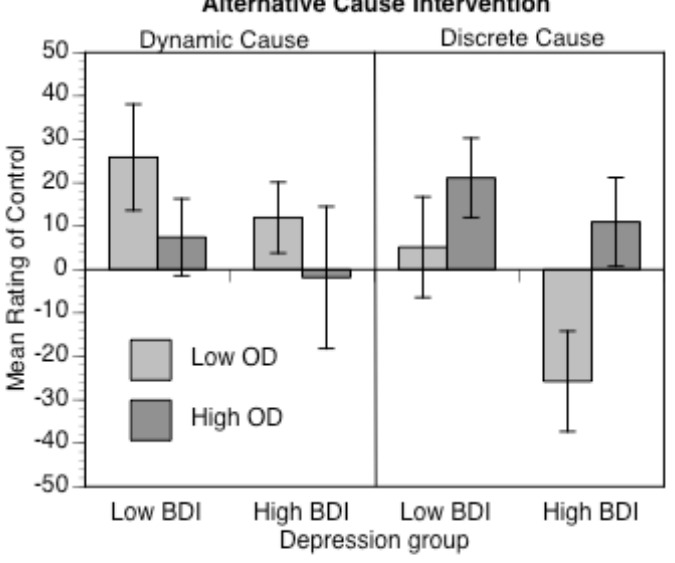
Figure 3. Mean ratings of control as a function of outcome density, Beck Depression Inventory (BDI) group and alternative cause intervention (error bars correspond to standard errors of the